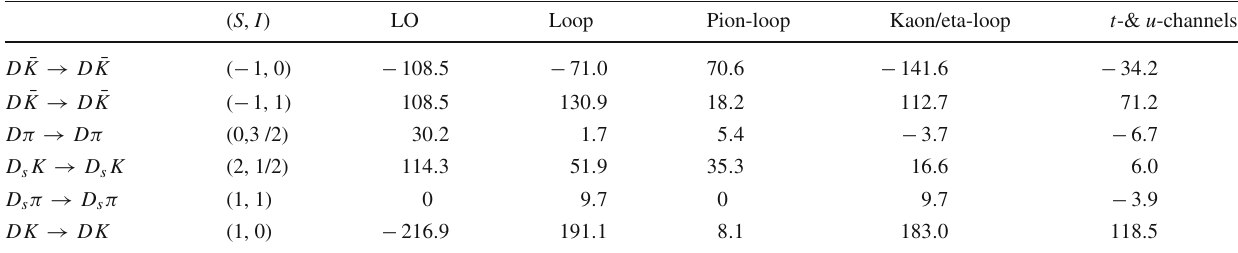
and sixth columns correspond to the loops with the pion and kaon/eta propagators, respectively. The last column corresponds to the t - and u -channel diagrams. The values are evaluated using physical masses at individual